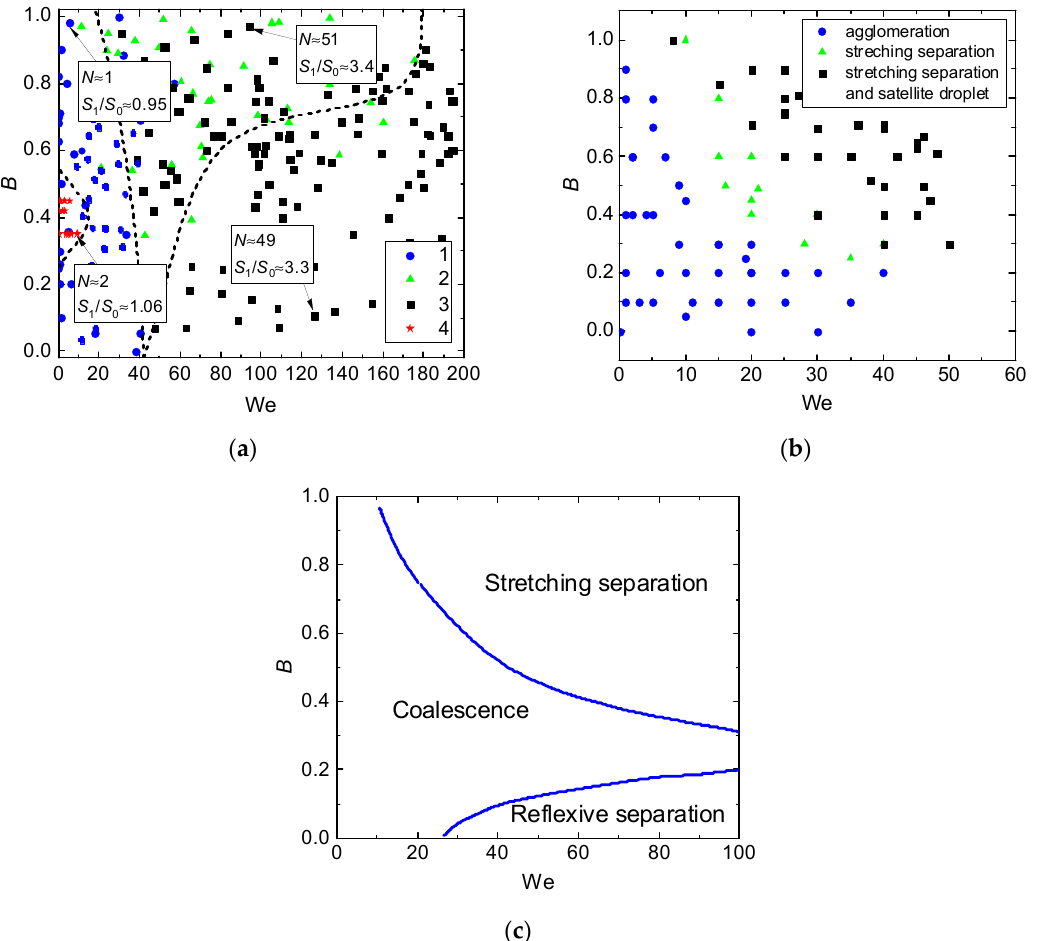
Figure 8. Interaction regime maps considering dimensionless linear parameter ( a ) for water slurry under study: 1—coalescence, 2—separation, 3—disruption, 4—bounce; ( b ) data for water [32]; ( c ) data for milk [39].